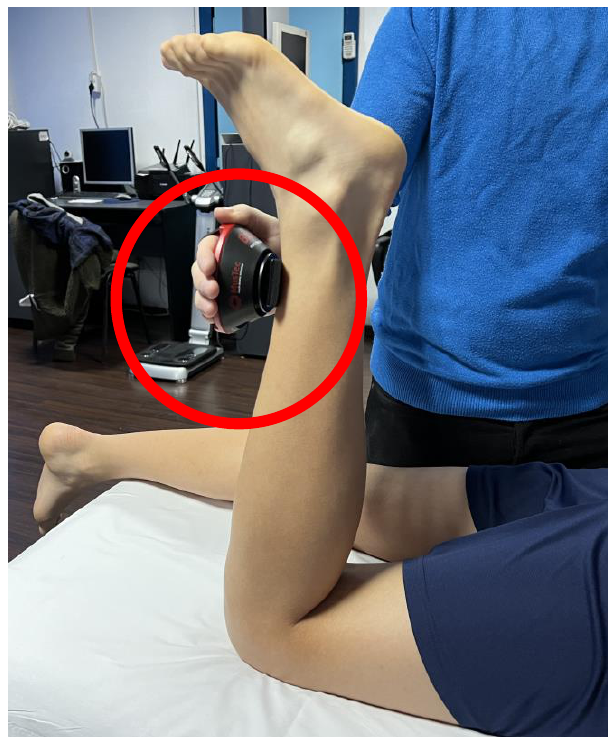
Figure 3. Test of knee extensors.